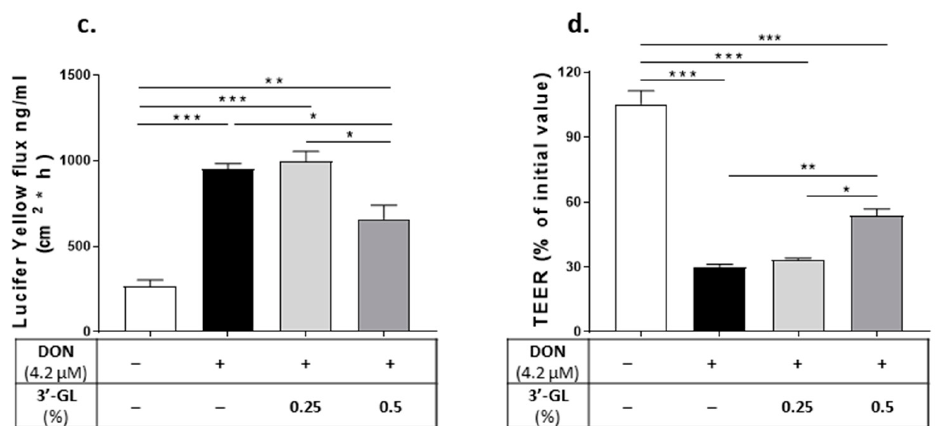
Figure 11. Protective effect of 3 ′ - galactosyllactose (GL) on deoxynivalenol (DON)-induced adverse effects on Caco-2 cell monolayer. Lactate dehydrogenase (LDH) release in cell supernatant ( a ); IL- 8/CXCL8 concentration in cell supernatant ( b ); trans-epithelial electrical resistance (TEER) ( c ); and lucifer yellow flux ( d ); Data are presented as mean ± SEM of 3 independent experiments performed in triplicate. * p < 0.05, ** p < 0.01 and *** p < 0.001 indicate statistical differences.